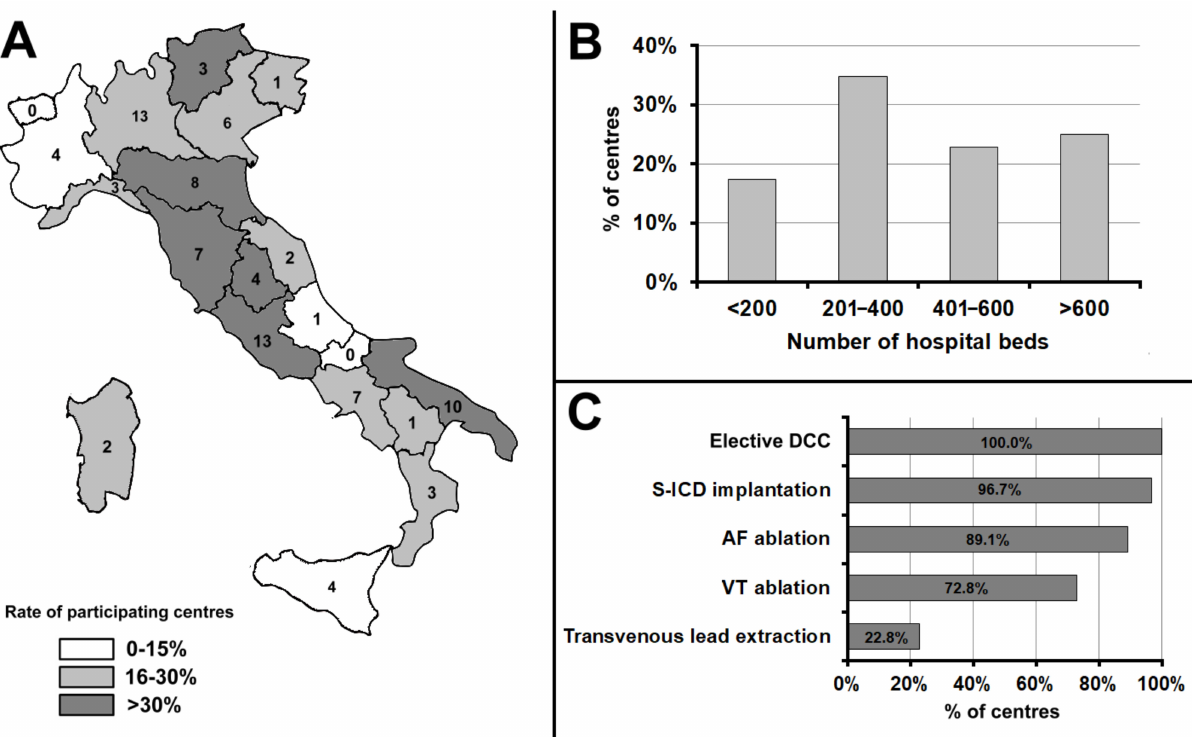
Figure 1. ( Panel A ): Geographic distribution of the centres that responded to the survey across Italy. ( Panel B ): Number of beds in the hospitals where the participating centres were located. ( Panel C ): Rate of centres where the electrophysiological procedures analysed were performed. Abbreviations used in the figure. AF: atrial fibrillation; DCC: direct-current cardioversion; S-ICD: subcutaneous implantable cardioverter-defibrillator; VT: ventricular